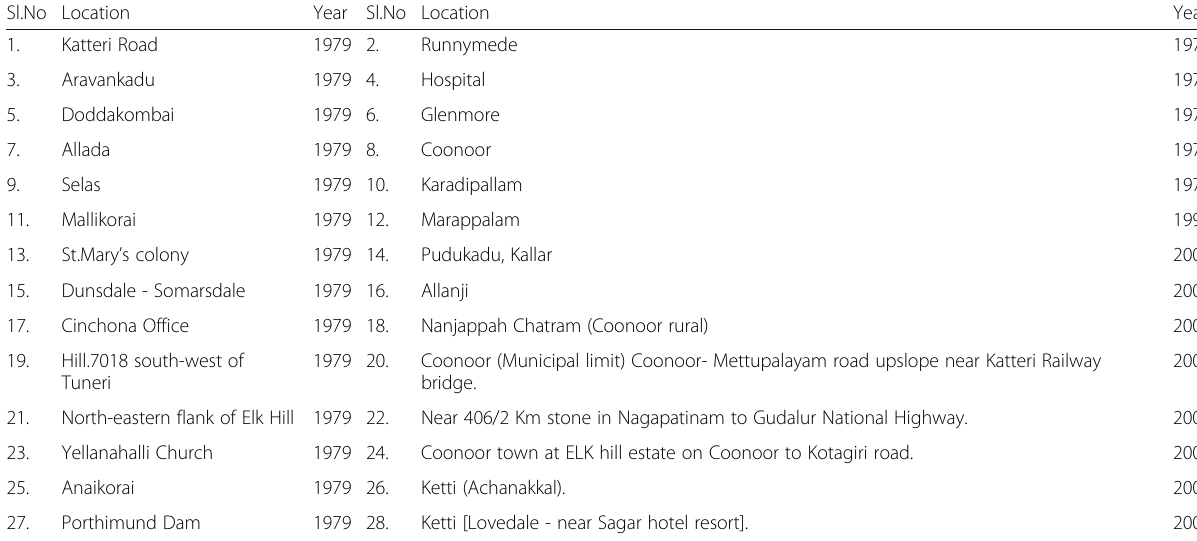
Table 2 Major Landslide Hotspots